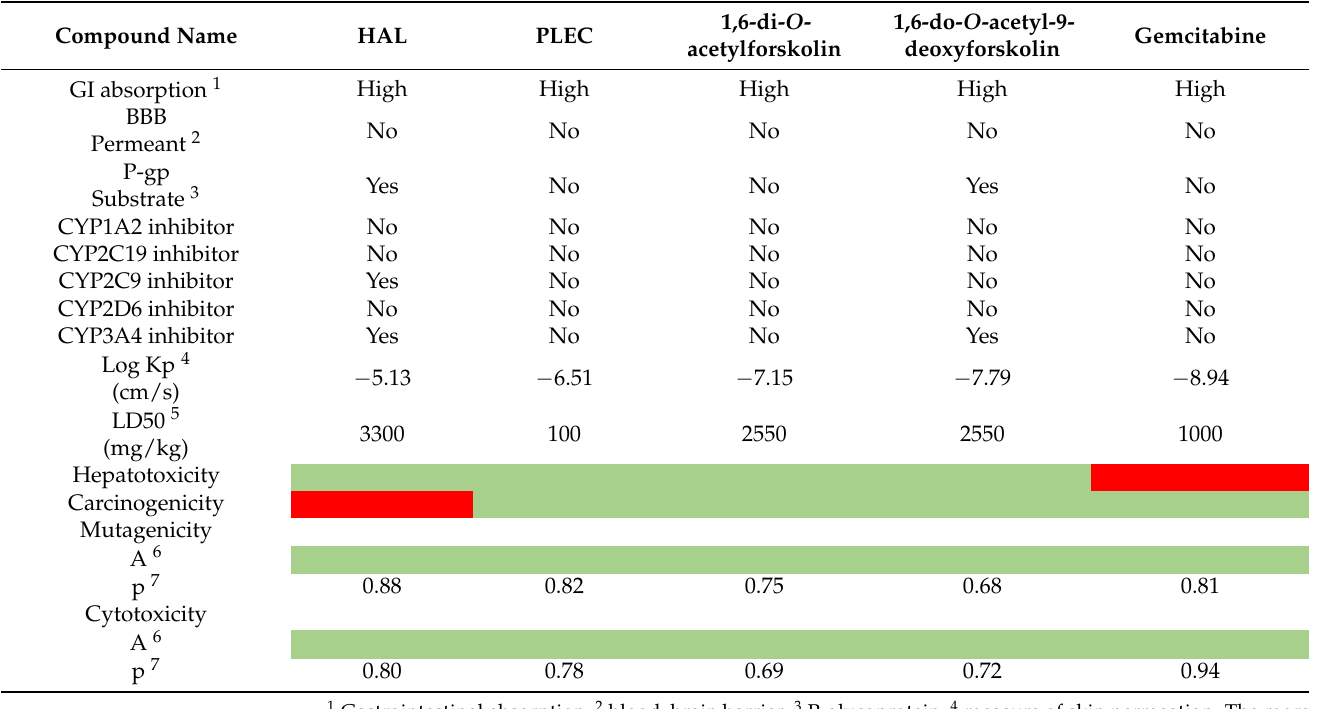
Table 2. Pharmacokinetic and toxicity predictions for plant-derived diterpenes and positive control—gemcitabine.